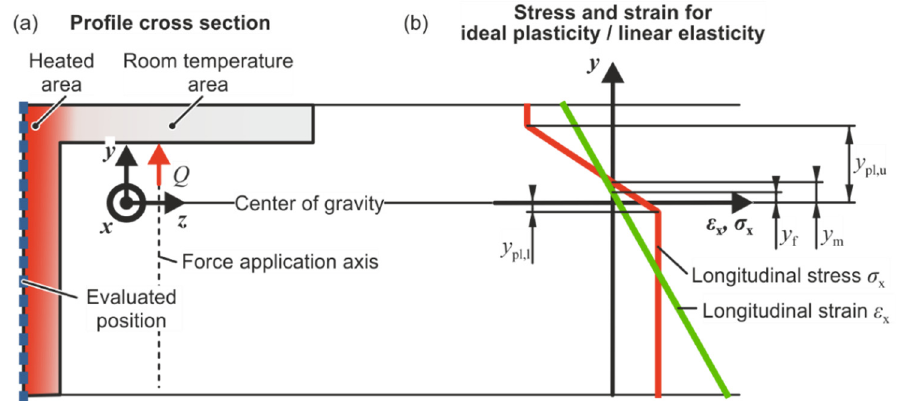
Figure 7. ( a ) profile cross-section of the partially heated profile, ( b ) longitudinal stress and strain progression for ideal plastic and linear elastic material behavior and partially plastic behavior over the cross section.